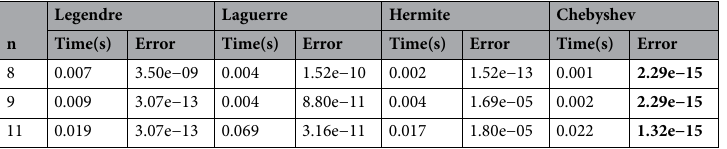
Table 6. Comparision of maximum relative error for Example 6.3 with different numbers of neurons. Significant values are in bold.